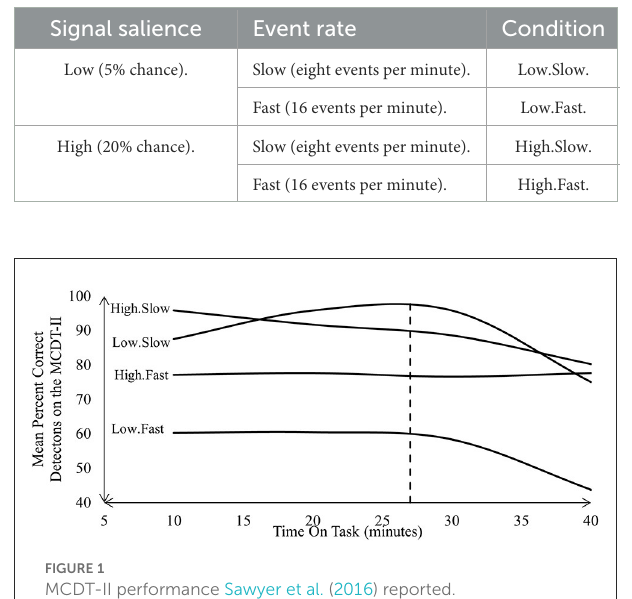
FIGURE1 MCDT-II performance Sawyer et al. (2016)